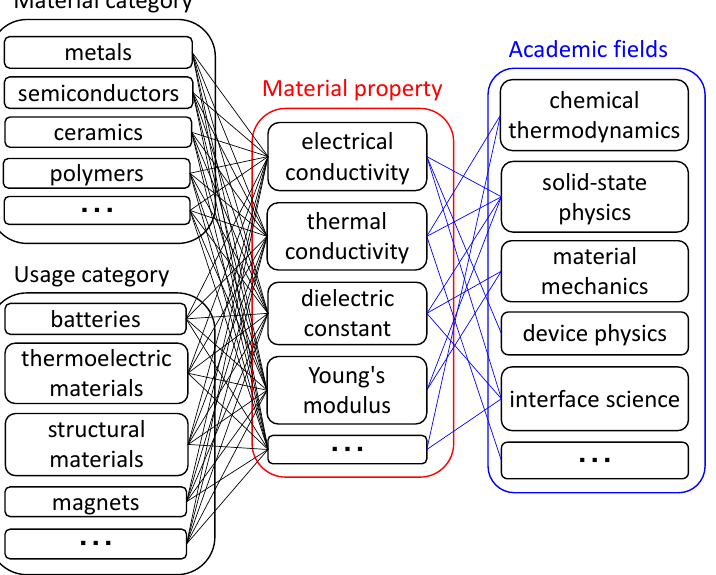
Figure 3. Schematic relationships among material properties (usually categorized by material type or usage; black lines) and scientific principles (usually categorized by academic fields; blue